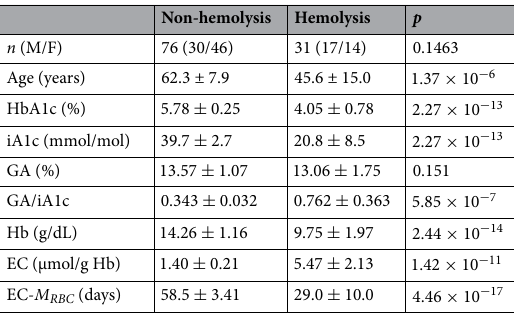
Table 1. Participants characteristics. Results are expressed as mean ± standard deviation (SD). Sex ratio was 2 examined by χ test. Other items were examined by t -test (bilateral). GA, glycated albumin; EC, erythrocyte